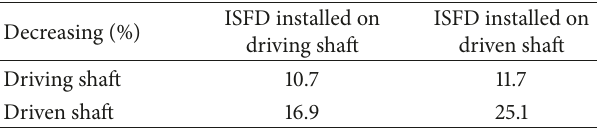
Table 4: Average amplitude of vibration reduction under two